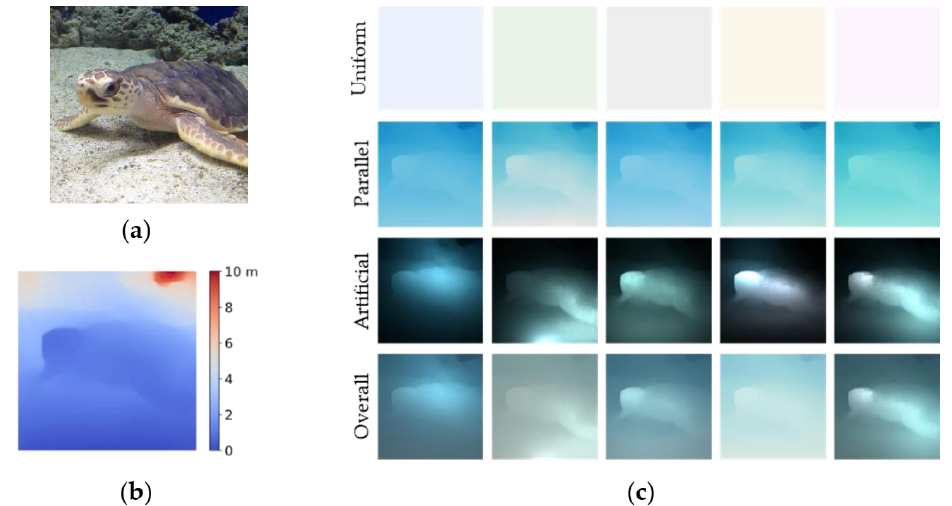
Figure 4. Examples of simulated underwater lighting parameters. ( a ) A clear image used to calculate scene structure (taken from the EUVP dataset). ( b ) Simulated transmission distance d ( x , y ) of the scene (method of simulating d ( x , y ) is given in the following parts). ( c ) Simulation results of underwater lighting parameters generated by using the transmission distance d ( x , y ) in ( b